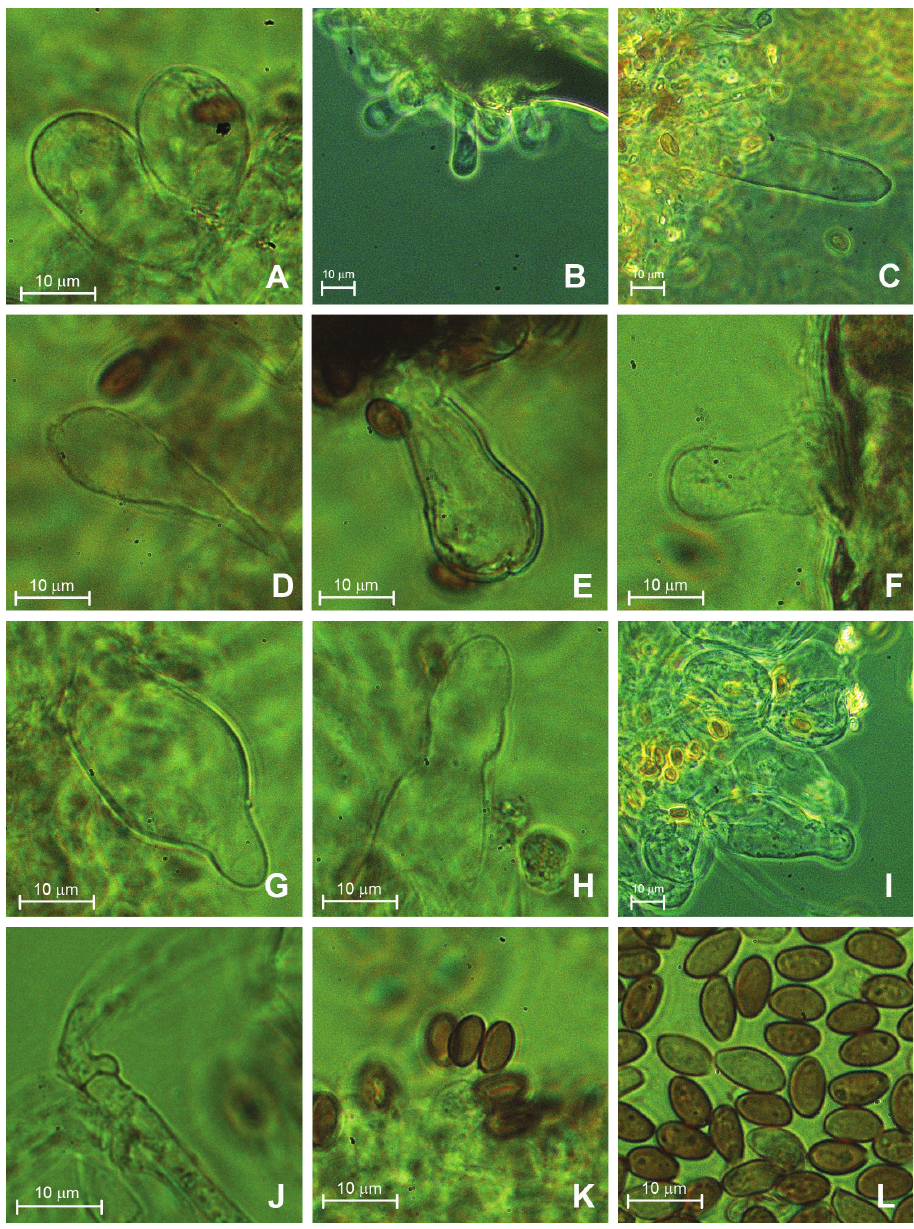
Figure 3. Micro-morphological characteristics of the Psathyrella mycelium: clavate and sphaeropedunculate ( A ), and cylindric ( B, C ) cells at a gill edge; differently clavate ( D, E ) and utriform ( F ) cheilocystidia; various- ly utriform-shaped pleurocystidia ( G, H, I ); a fibulate hypha ( J ); a 4-spored basidium ( K ); basidiospores ( L